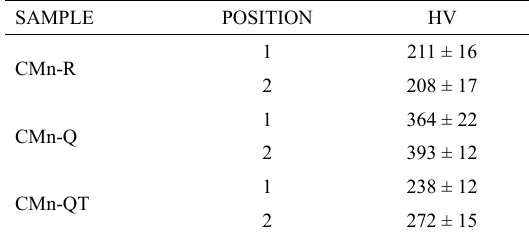
CMn-R: as-rolled steel; CMn-Q: rolled and quenched steel; CMn-QT: quenched and tempering steel; Position 1: outer region; Position 2: inner